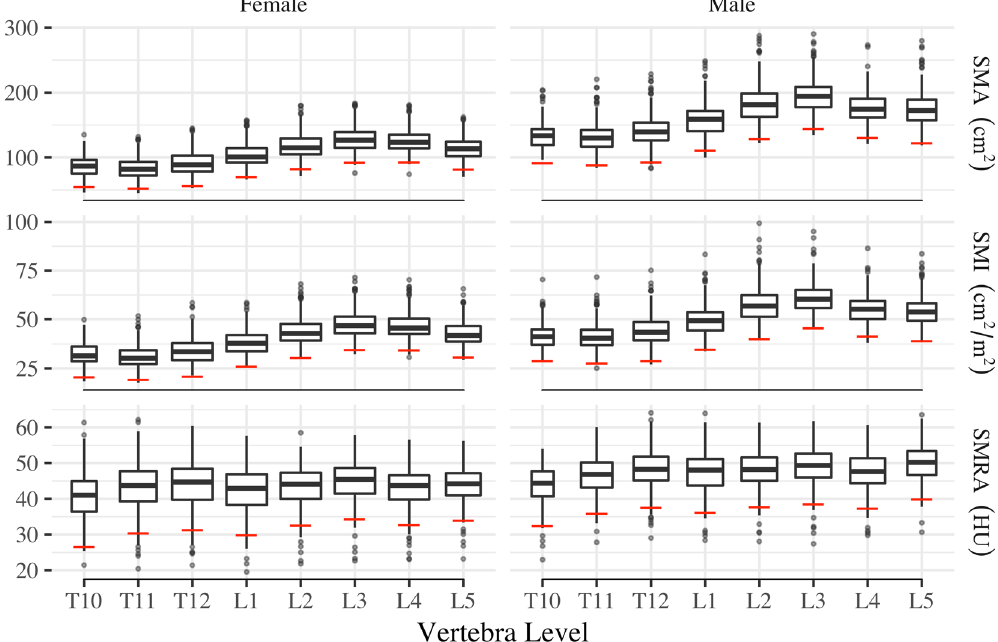
Figure 1. Box plots of healthy reference population SMA, SMI, and SMRA values by sex and vertebra. EWGSOP sarcopenia cutoffs (mean − 2 s.d.) shown as horizontal red lines.